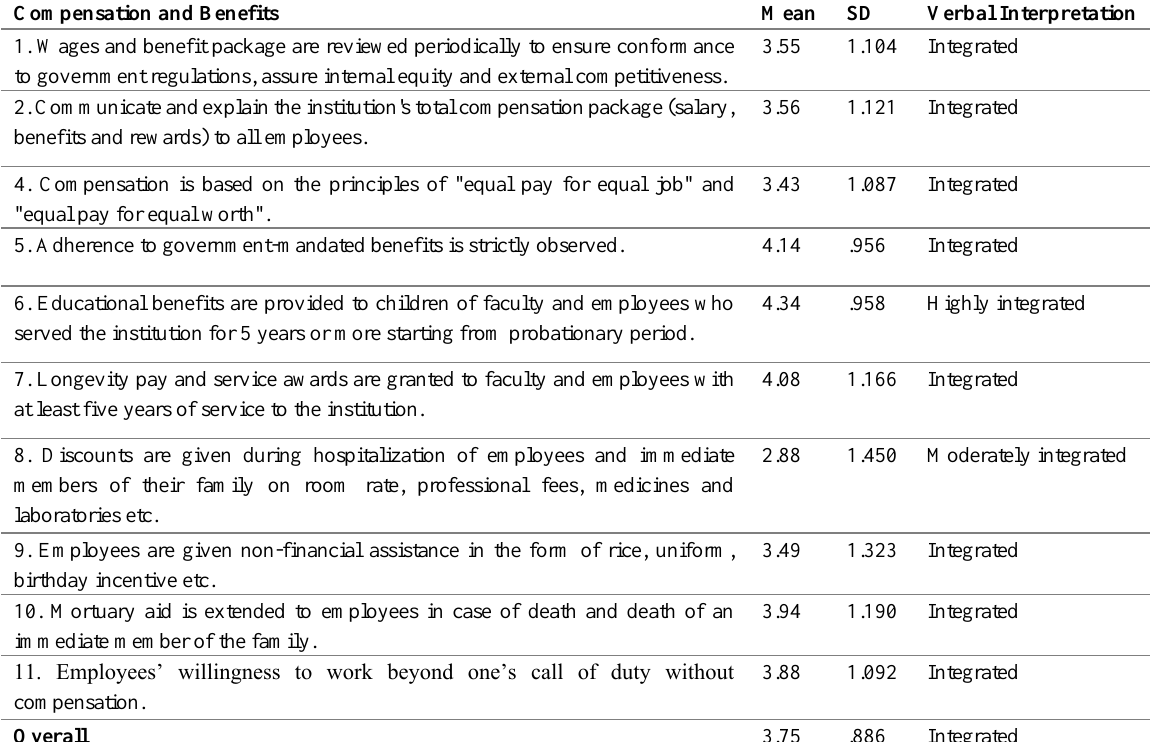
Table 6: Extent of Integration of Commitment to the Compensation and Benefits as Perceived by Respondents Compensation and